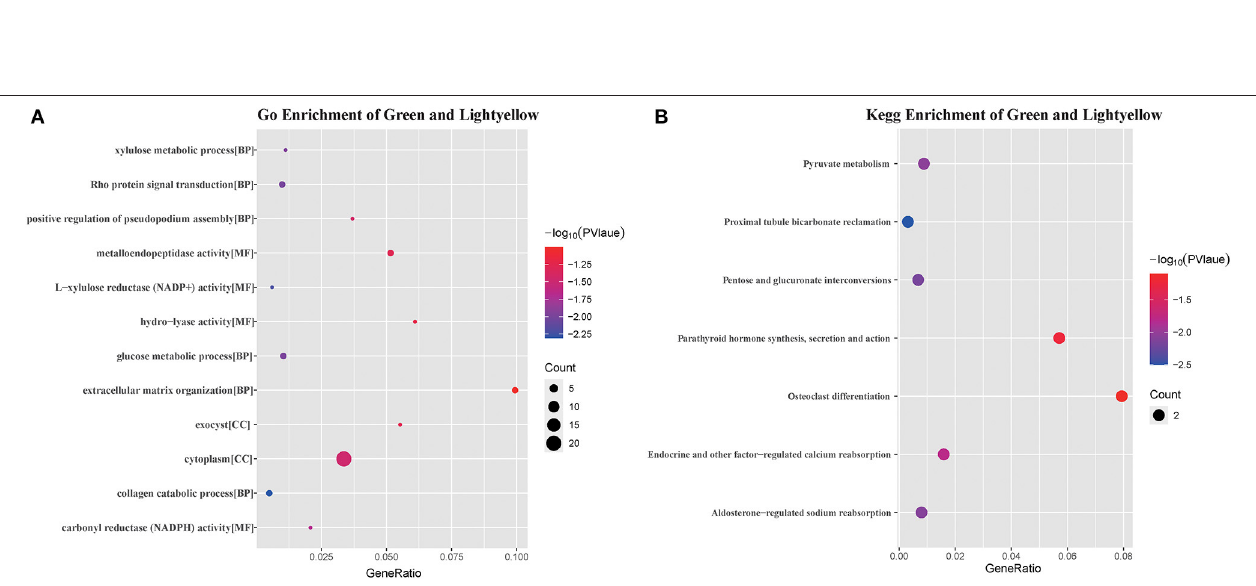
FIGURE 7 | GO analysis and KEGG pathway enrichment results of genes in green and light yellow module. (A) GO enrichment results for the green and light yellow module, the bubble size shows the number of enriched GO terms containing genes from the green and light yellow module, the color represents the significance score of the enrichment, and the bubble nodes represent the ratio of the enriched genes to the GO terms. (B) KEGG enrichment of green and light yellow modules, bubble size shows the number of genes enriched to the biological pathway lexicon containing green and light yellow modules, color represents the color represents the significance score of enrichment, and bubble nodes represent the ratio of enriched genes to the KEGG